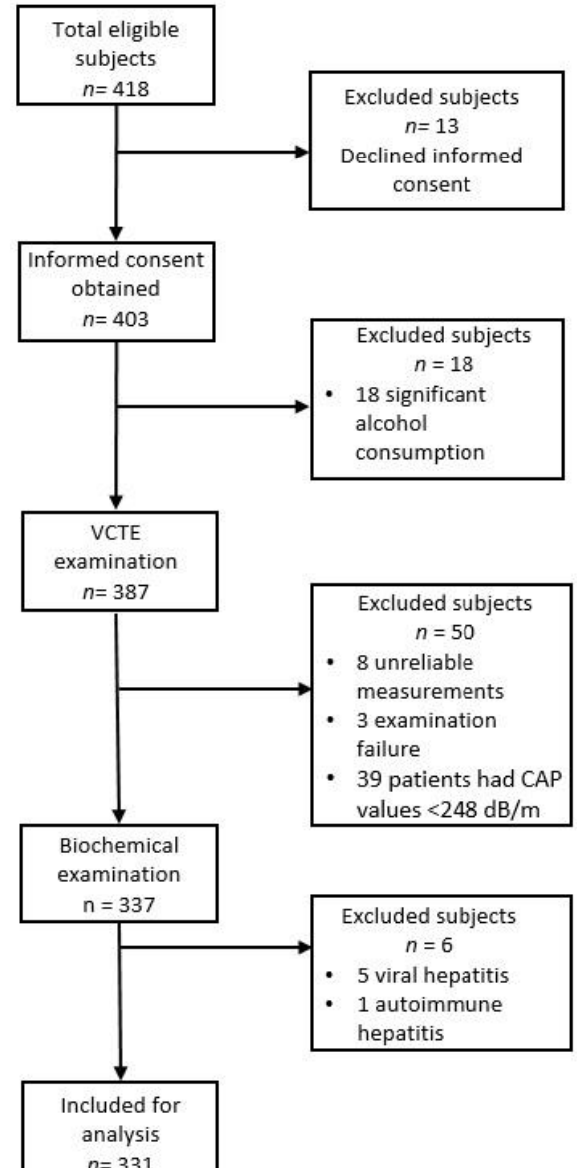
Figure 1. Participant flowchart.